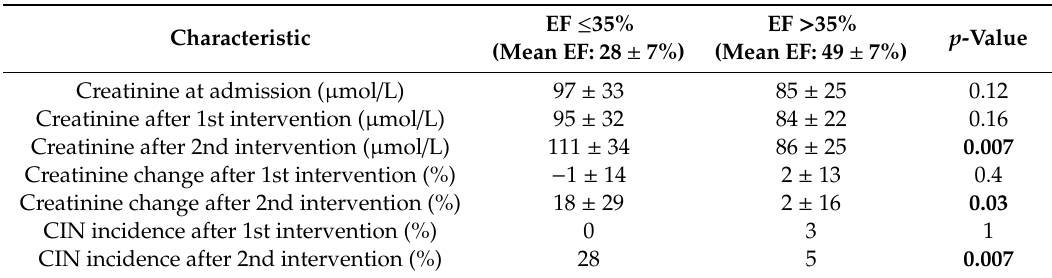
Table 2. Serum creatinine, its post-procedural changes and CIN incidence after the 1st and 2nd interventions according to low EF after the 1st angioplasty ( ≤ 35%) in patients undergoing two-stage complete coronary revascularization during hospitalization for AMI.